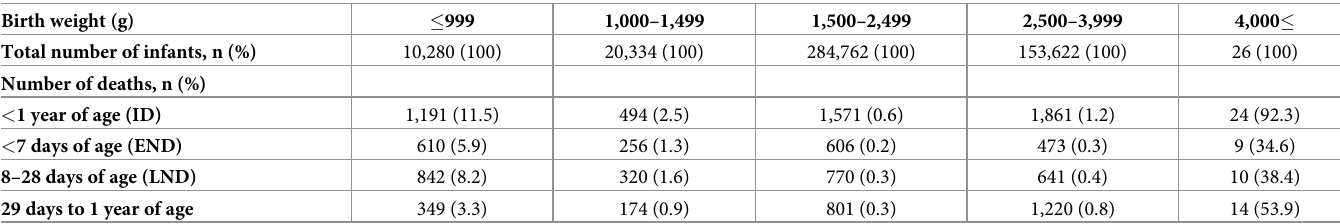
Table 2. Relationship between early neonatal death/neonatal death and birth weight.